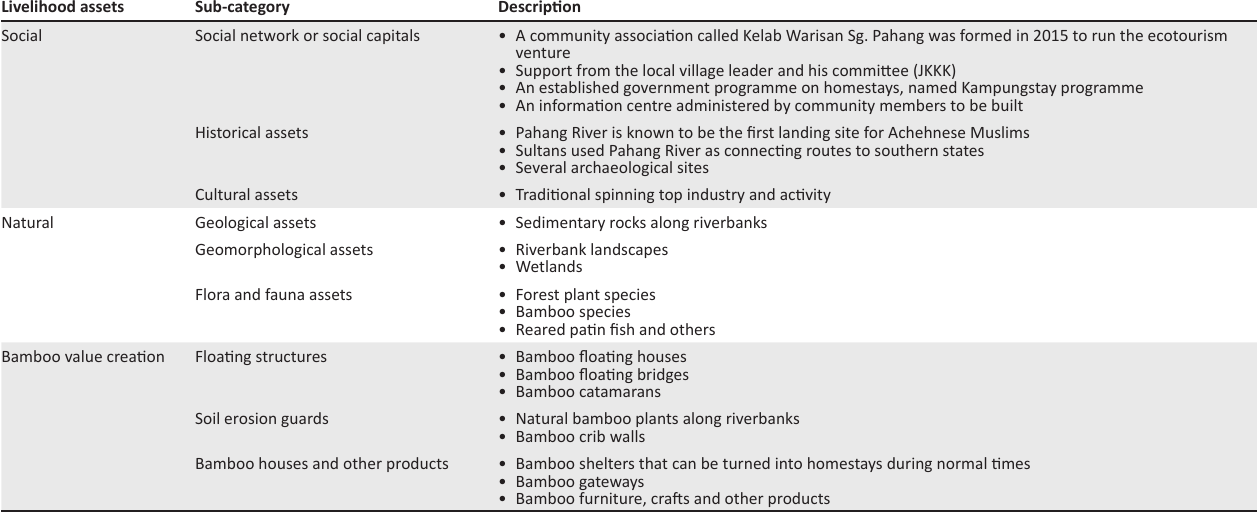
TABLE 1: Livelihood assets that can contribute to the development of ecotourism in Kg. Mengkarak, Pahang. Livelihood